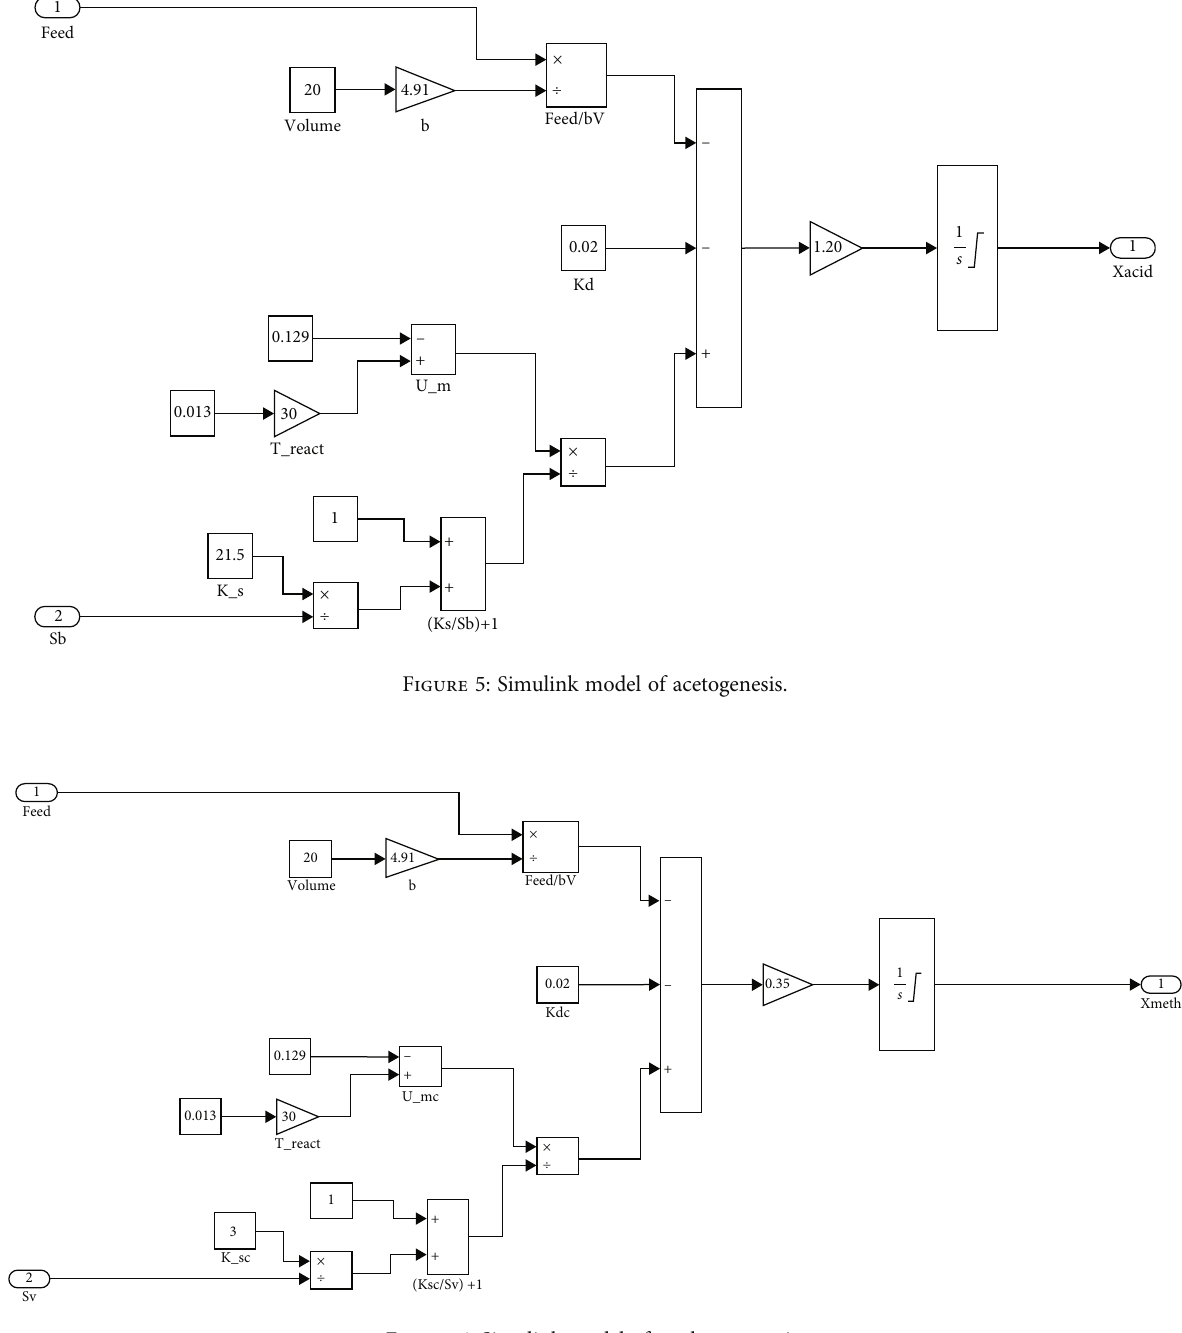
Figure 6: Simulink model of